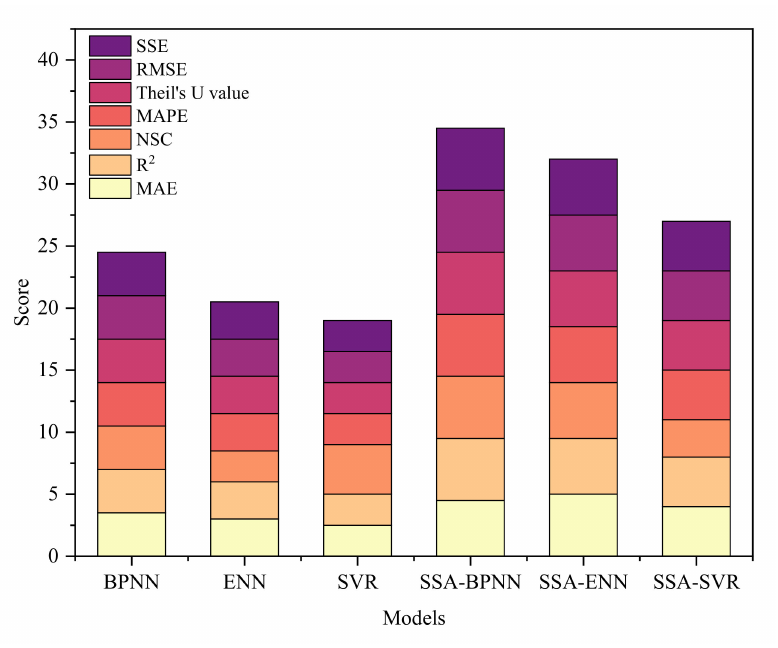
Figure 19. Stacked chart of index scores for all models.